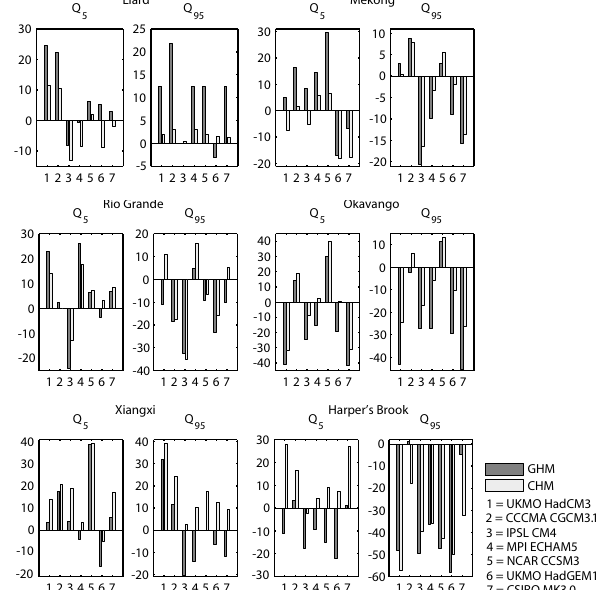
Fig. 9. Baseline and projected mean-monthly runoff simulated by the GHM and CHM respectively (expressed as a percentage of the mean annual total runoff) when they are forced by 7 GCMs under 2 ◦ C prescribed warming, for each catchment. The light grey and dark grey lines show the ensemble mean across the 7 GCMs for the CHM and GHM respectively, with the shaded region denoting the inter-GCM range.